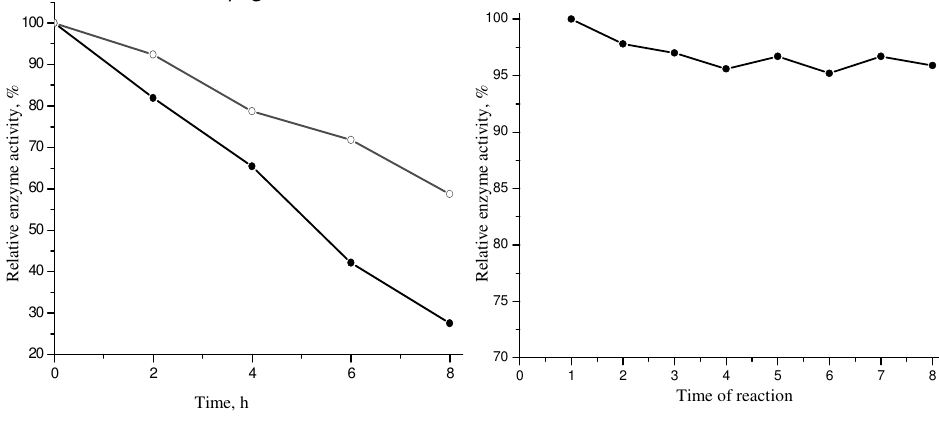
Figure 6. Effect of temperature on the stability of free (a) and immobilized (b) enzymes at 50 o C